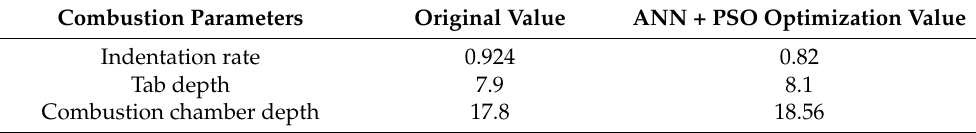
Table 3. Comparison of combustion chamber parameters before and after optimization.